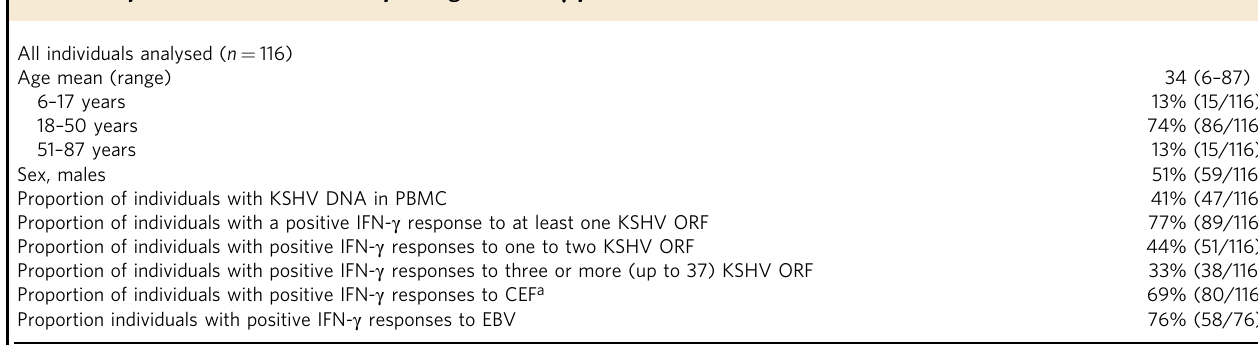
Table 1 Proportions of individuals responding with IFN- γ production and their overall